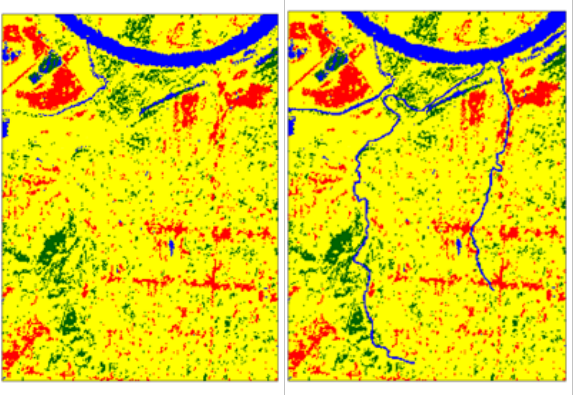
Figure 1. Rock Creek & Sugar Creek in Shoal Creek-Missouri River Watersheds, 1992. On the right image, two fine stream lines are revealed by the knowledge-based